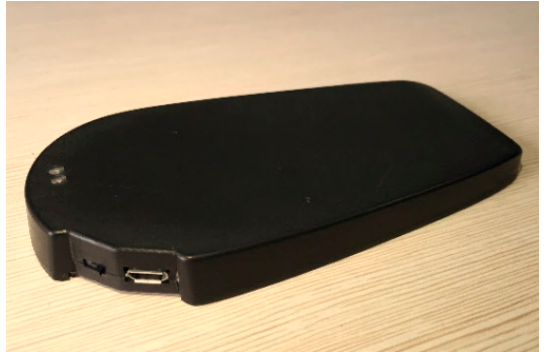
Figure 5. The insole-shaped MIMU module.